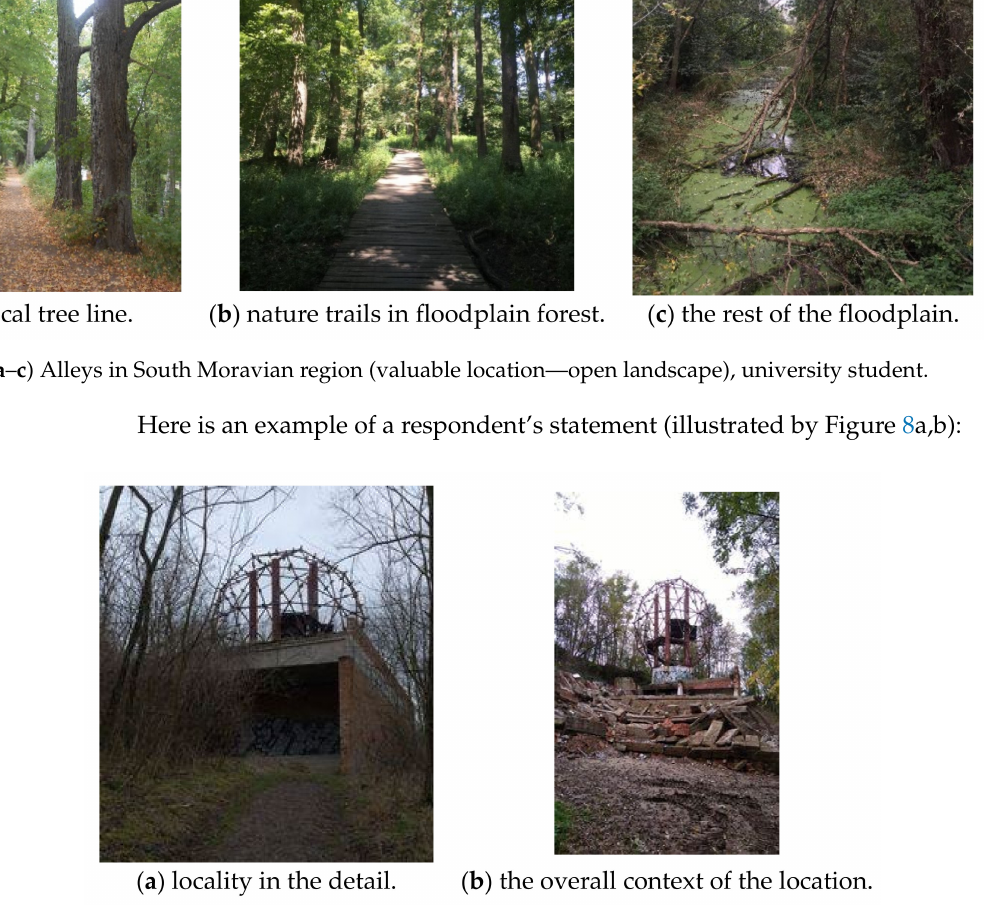
Figure 8. ( a , b ) Unfinished monument (Kˇrepice)—dilapidated structure (valuable location—open landscape), university